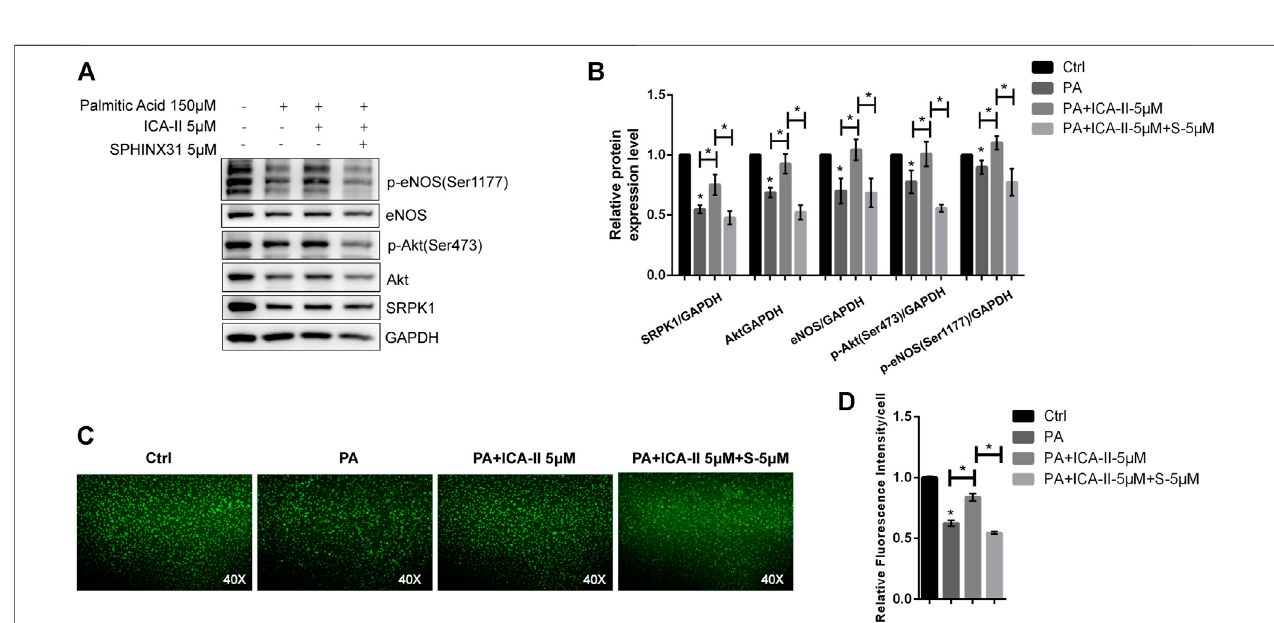
FIGURE 7 | ICA Ⅱ restores SRPK1/Akt/eNOS pathway in PA-treated HUVECs. HUVECs were treated with 5 μ M SPHINX31, followed by stimulation with PA (150 μ M) in the presence or absence of ICA Ⅱ (5 μ M) for 24 h that was pretreated for 1 h. The levels of eNOS, phosphor-eNOS (Ser1177), Akt, phosphor-Akt (Ser473), and SRPK1 were determined by western blot (A) with the quanti fi cations of the related proteins (B) . The immuno fl uorescence images of the NO probe were observed using40× fl uorescencemicroscopy (C) withthequanti fi cationsofmean fl uorescenceintensity (D) .Thedataarepresentedasthemean±SDofthreeindependent experiments. Signi fi cance was determined by one-way ANOVA with a least signi fi cant difference post hoc test. ns, p > 0.05; *, p < 0.05 vs Ctrl.